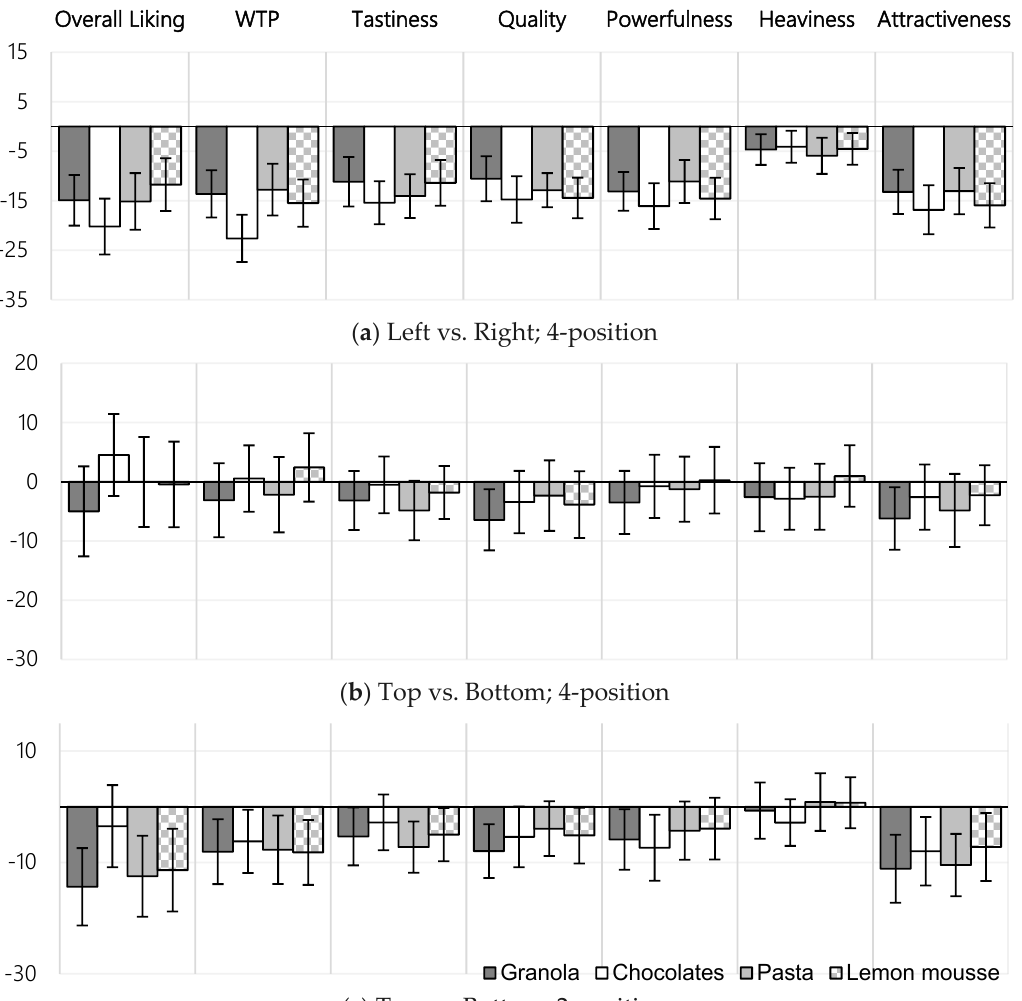
Figure 2. Mean difference between window positions, by measure, clustered by product category. ( a ) The average effect of horizontal window position (average score for left-aligned windows, minus average score for right-aligned windows; i.e., a negative difference shows a higher average score from the stimuli with right-aligned windows), using mean differences from the 4-position stimulus set; ( b ) the average effect of vertical position (average score for top-aligned windows, minus average score for bottom-aligned windows; i.e., a negative difference shows a higher average score from the stimuli with bottom-aligned windows), using mean differences from the 4-position stimulus set; and ( c ) the average effect of vertical position (as above) using mean differences from the 2-position stimulus set. Error bars show the 95% confidence interval about the